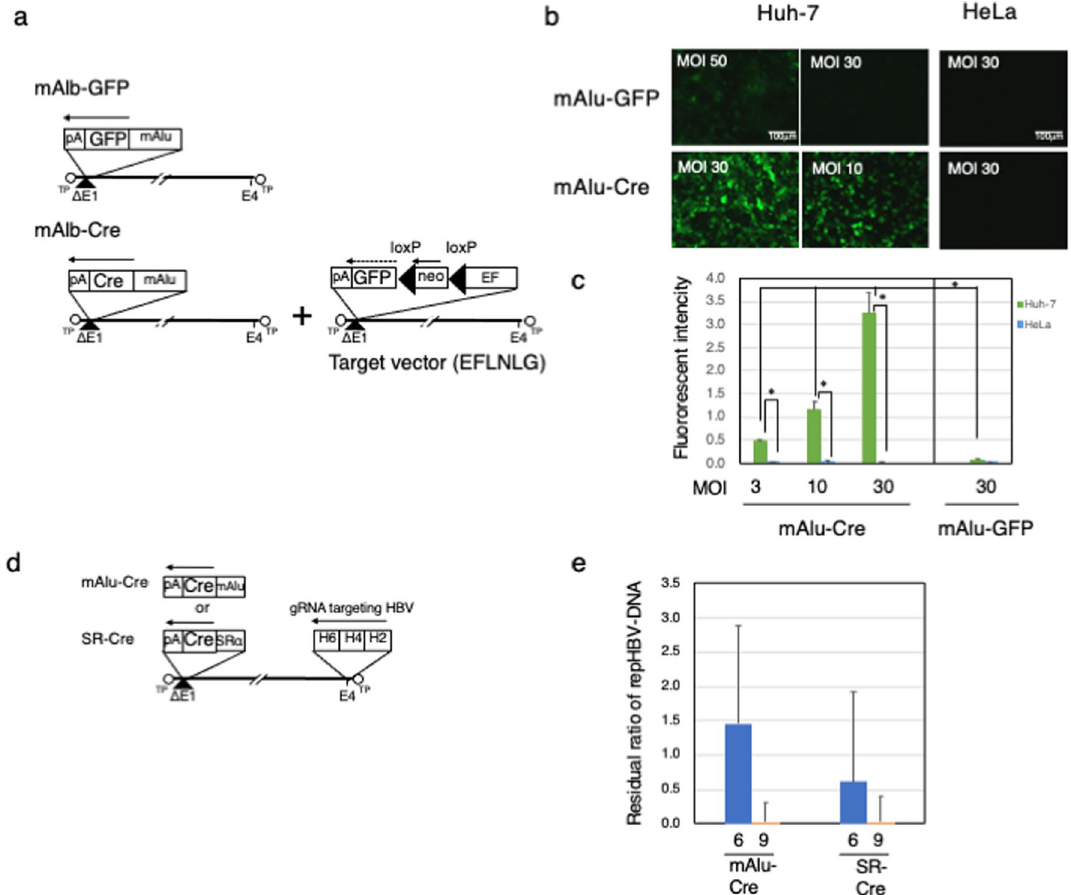
Figure 3. Cell-specific genome editing using Exci-Cas9. ( a ) AdVs to verify cell-specific promoter activity. ( b ) Fluorescence micrographs of Huh-7 or HeLa cells expressing GFP directly from the mAlu promoter or in a Cre- dependent manner expressed from the mAlu promoter. ( c ) Measured amount of GFP fluorescence. (post-test; *p < 0.0001). ( d ) AdVs for cell-specific genome editing of the HBV genome. mAlu-Cre or SR-Cre used the mAlu promoter or SRα promoter to express Cre, respectively. ( e ) Efficient elimination of HBV DNA by cell-specific Exci-Cas9. TaqMan PCR was performed in the same manner as in Fig. 2. The blue and orange columns show the values at 6 and 9 days after HBV-AdV transduction, respectively. The reproducibility was confirmed in two experiments, and the data of n = 3 was